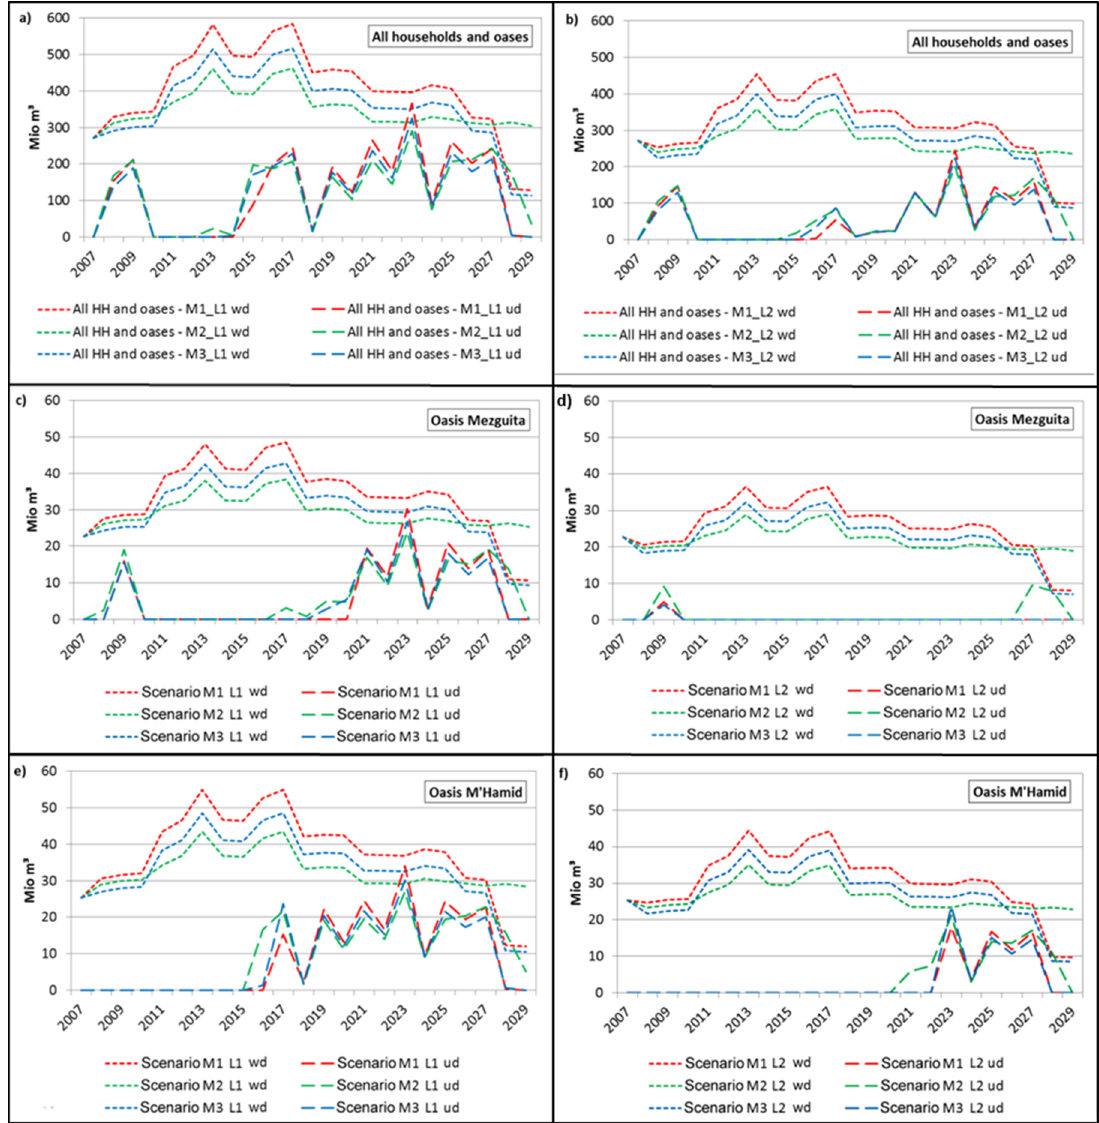
Figure 8. Mean annual water demand (wd, small dashed lines) and unmet demand (ud, long dashed lines) in million m 3 ( a , b ) of the three scenarios M1 (red), M2 (green), and M3 (blue) (2007–2029) under the sub-scenarios L1 and L2; ( c , d ) of the oasis Mezguita; ( e , f ) of the oasis M’Hamid. Water demand and unmet demand show less magnitude in the sub-scenario L2.